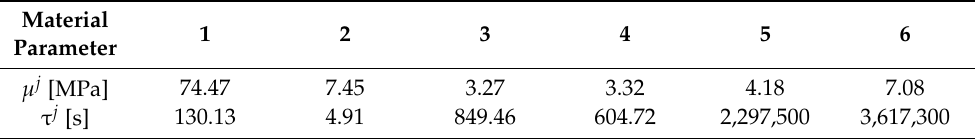
Table 3. Identified material parameters based on finite strain relaxation tests at θ = 10 ◦ C.